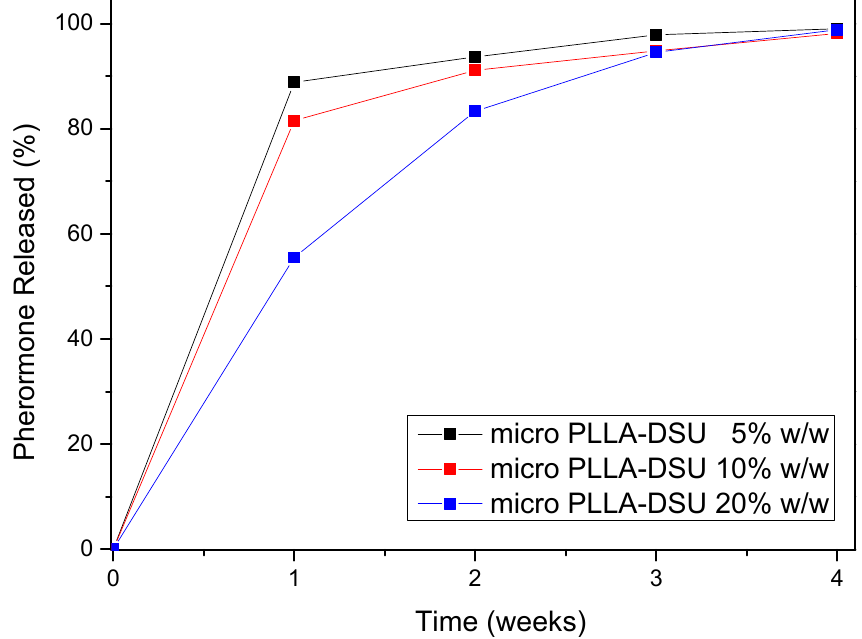
Figure 8. Release (%) of pheromone from PLLA microspheres after HS-SPME.